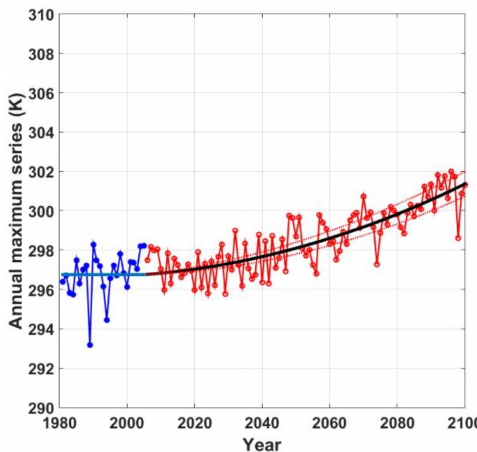
Figure 7. Future annual maximum persistence interval 24-h dew-point temperature for Hadgem3-RA and RCP 8.5 at Seoul station in the first half of August.